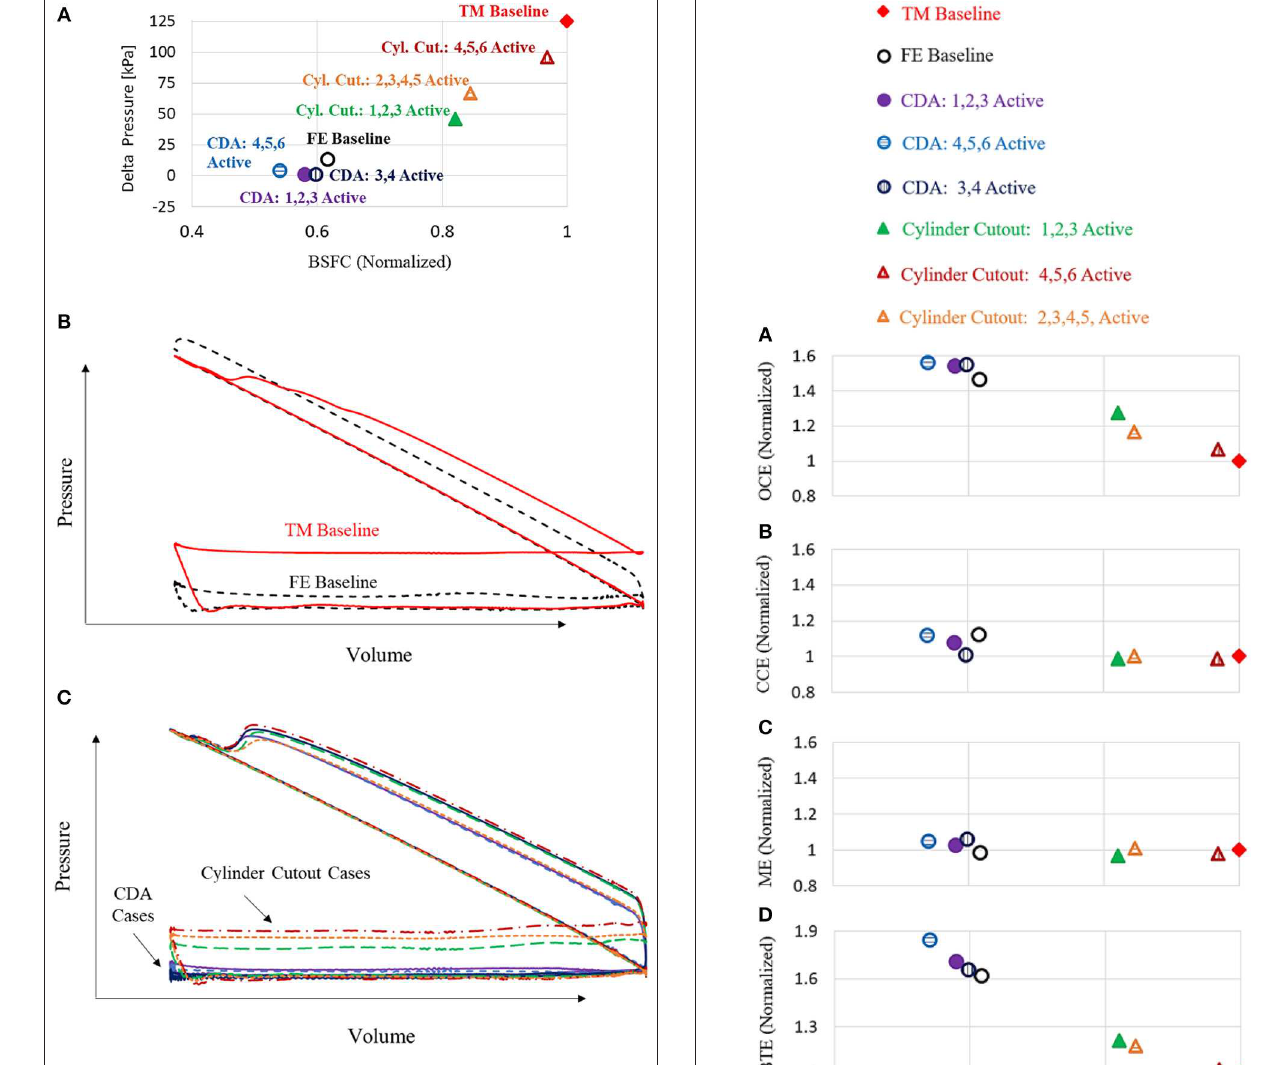
FIGURE 8 | (A) Delta pressures between the exhaust and intake manifolds for each of the tested strategies. (B) LogP-LogV representation of the firing cylinders in the FE Baseline and TM Baseline operation. (C) LogP-LogV representation of the firing cylinders in CDA and Cylinder Cutout operation.